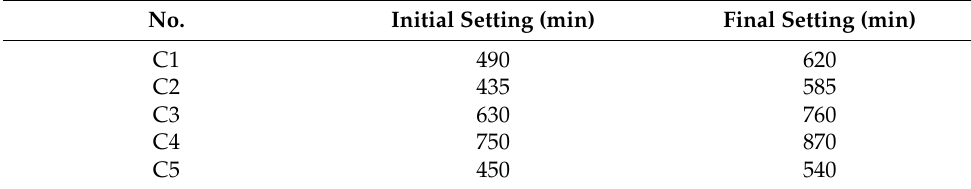
Table 3. The setting times of SCC mixtures.